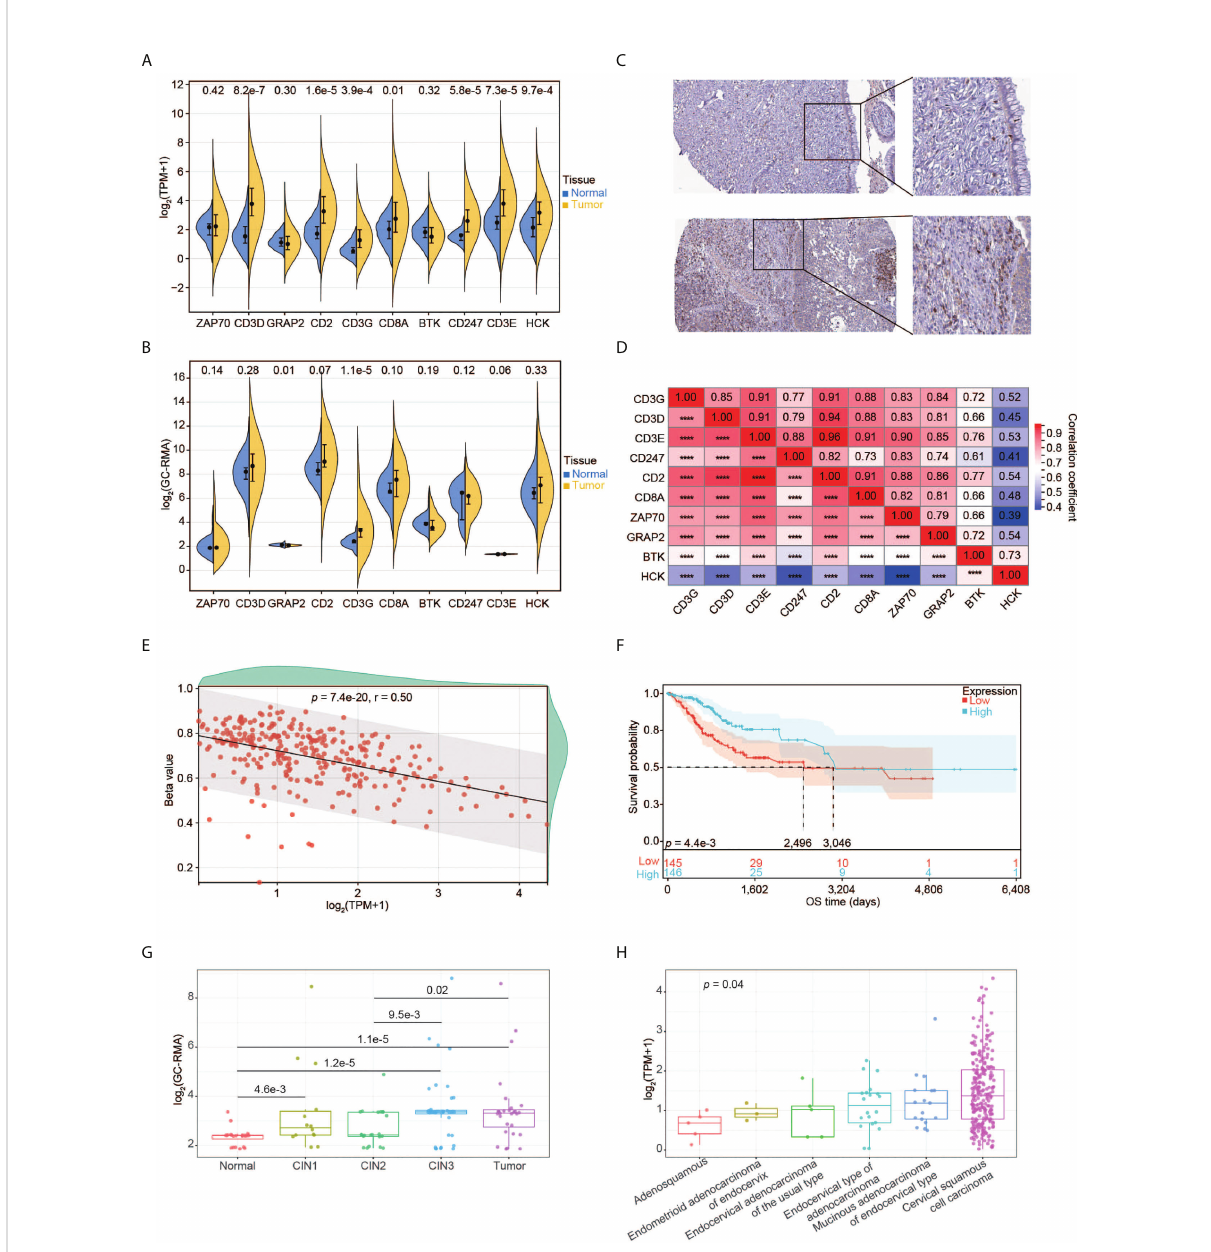
FIGURE 5 Expression pattern of CD3G as the key gene in CESC. (A) The expression pro fi les of the 10 key genes in normal tissues and tumors. (B) The expression pro fi les of the 10 key genes validated using GSE63514. (C) CD3G protein expression based on Immunohistochemistry data from the HPA database. Up panel: normal tissue. Down panel: CESC tissue. Antibody: HPA038494. The patient id of the normal cervix tissue is 1773. It has no detectable score of antibody staining. The patient id of the tumor tissue is 1751. It has medium staining, moderate intensity, and 75%-25% quantity score. (D) The co-expression of the 10 key genes in CESC. **** p < 0.0001. (E) The methylation pattern of CD3G in CESC. (F) OS analysis of high and low CD3G expression for TCGA-CESC patients. (G) The association of CD3G expression with CIN lesion. (H) The association of CD3G expression with histological